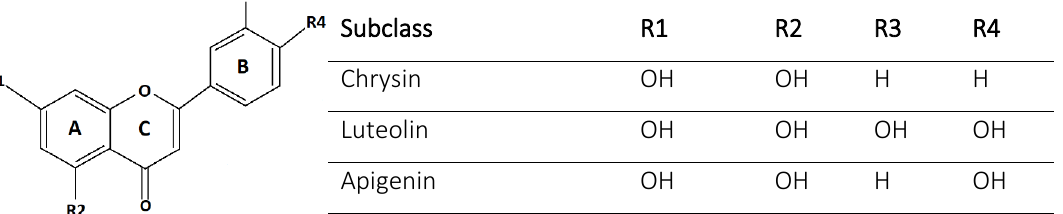
Figure 4. Flavonones: chemical structures, types and substitution positions in the basic skeleton.